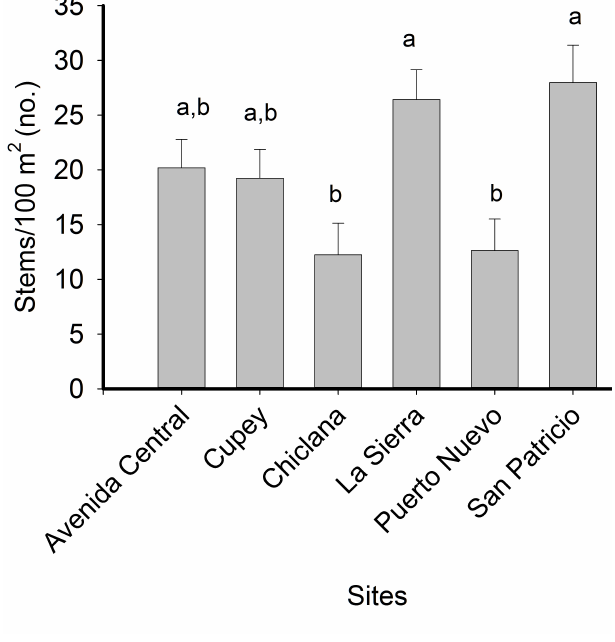
Fig. 4 . Frequency of stems per yard across sites within the Rio Piedras watershed. Stem density: F5,405 = 2.29, p = 0.04. Different letters indicate significant differences among sites at p < 0.05 using Tukey–Kramer tests.